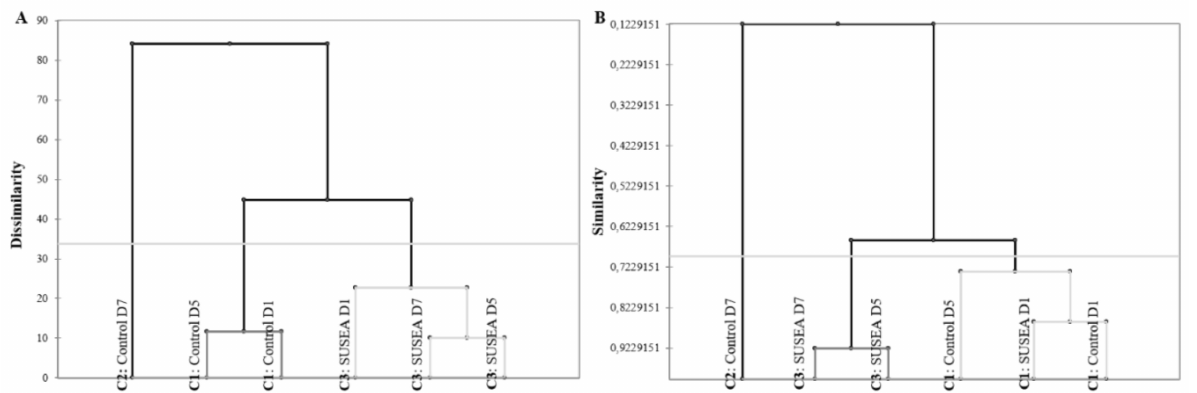
Figure 4. Agglomerative Hierarchical Clustering (AHC) dendrograms for ( A ) Dissimilarity and ( B ) Similarity samples (Control (untreated) and SUSEA (treated) gilthead seabream fillets) based on the descriptive analysis profiling data. C stands for